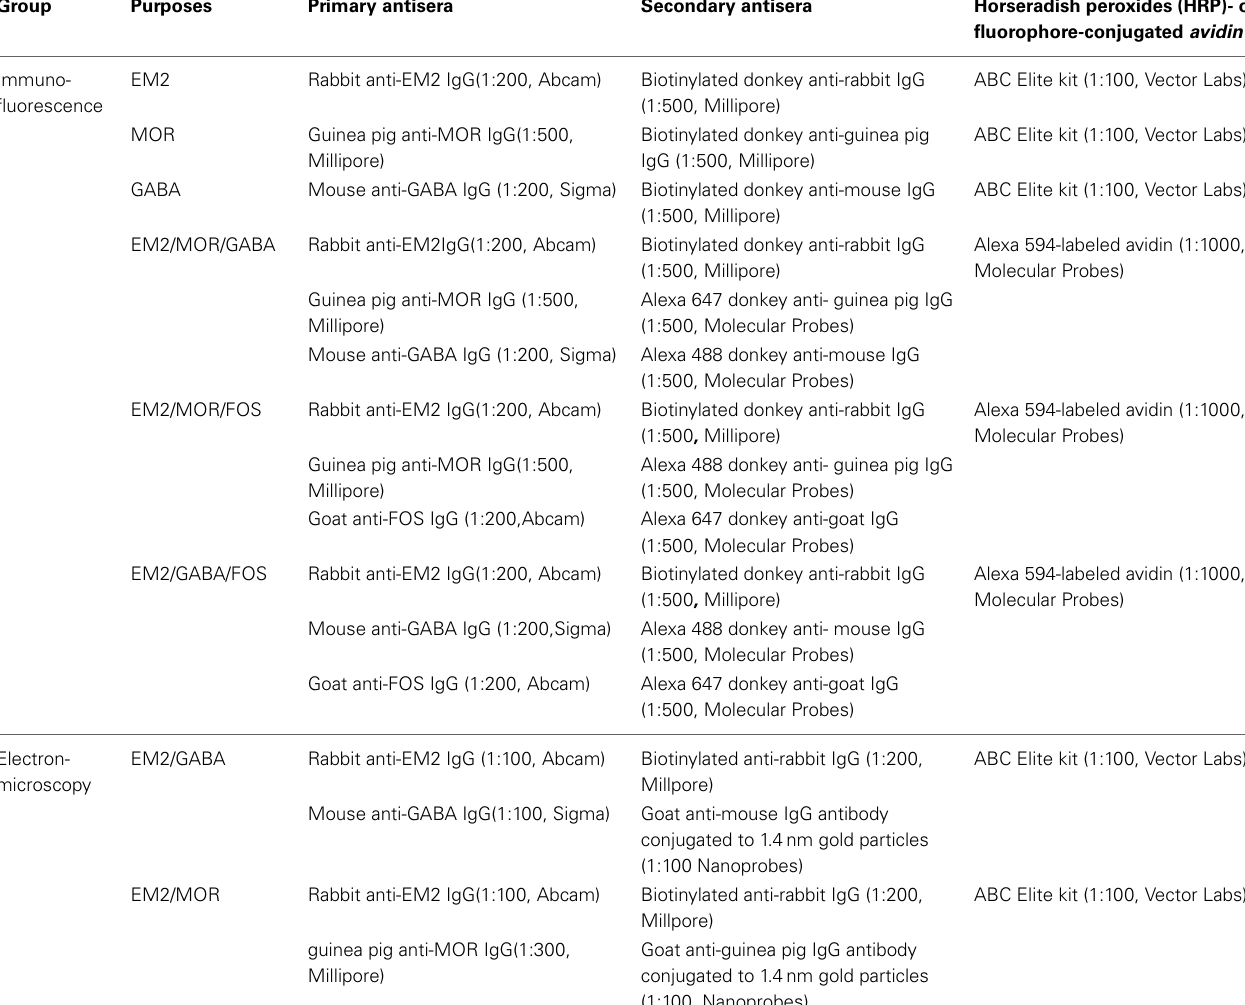
Table 1 | Antisera used in each group.